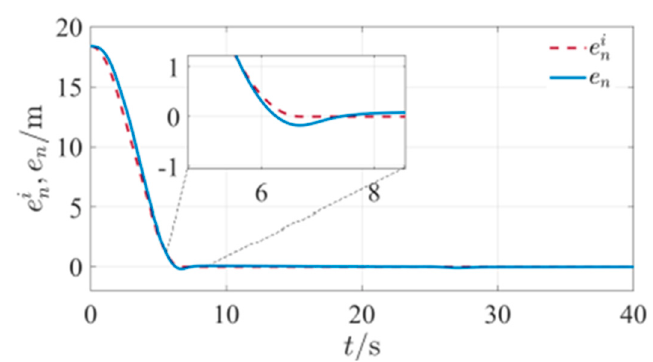
Figure 24. Diagram of normal error.